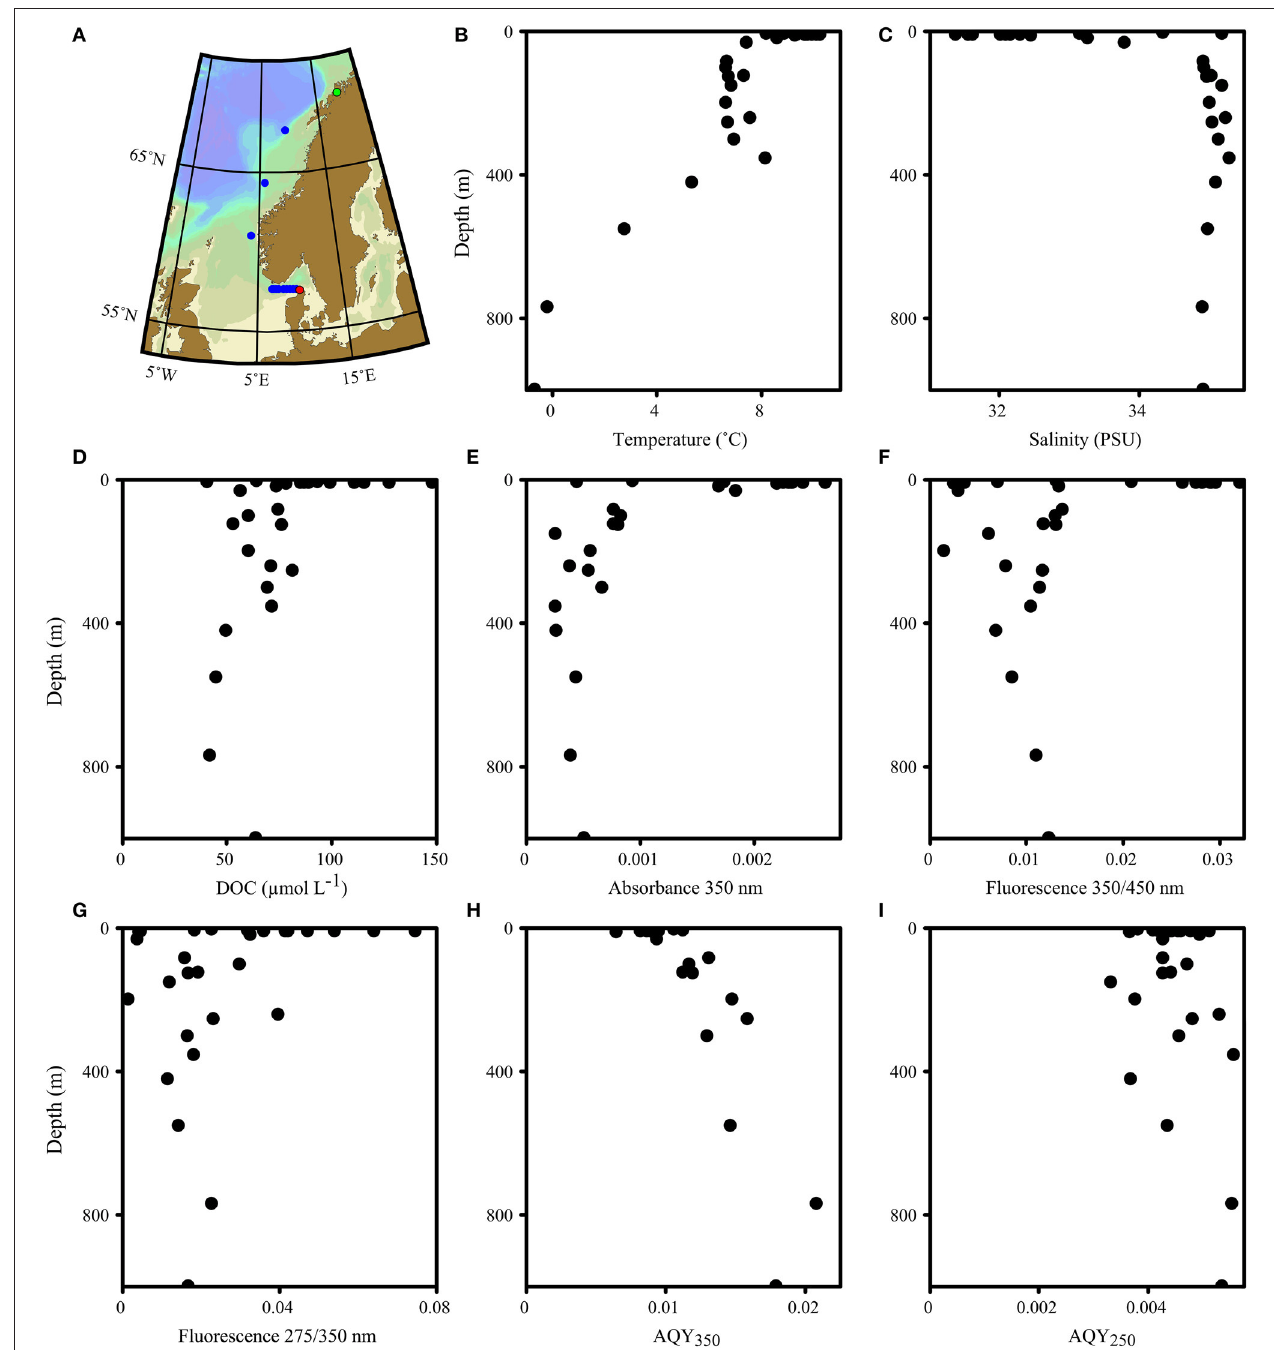
FIGURE 1 | Map (A) and vertical profiles of various biogeochemical parameters (B–I) of the transect along the Norwegian shelf and the Skagerrak. The transect direction was north (starting in Tromsø, green dot) to south (ending in Hirtshals, red dot). A total of 11 stations were sampled. Eight stations in the Skagerrak were sampled for surface waters; three stations along the Norwegian shelf included vertical profiles.